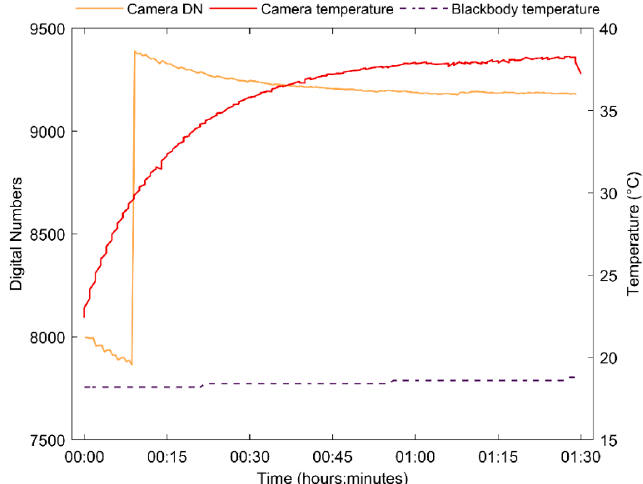
Figure A1. Repetition of the camera stabilization experiment: time series of mean camera digital number, temperature of the camera and blackbody temperature for the first 1.5 hours after camera activation.